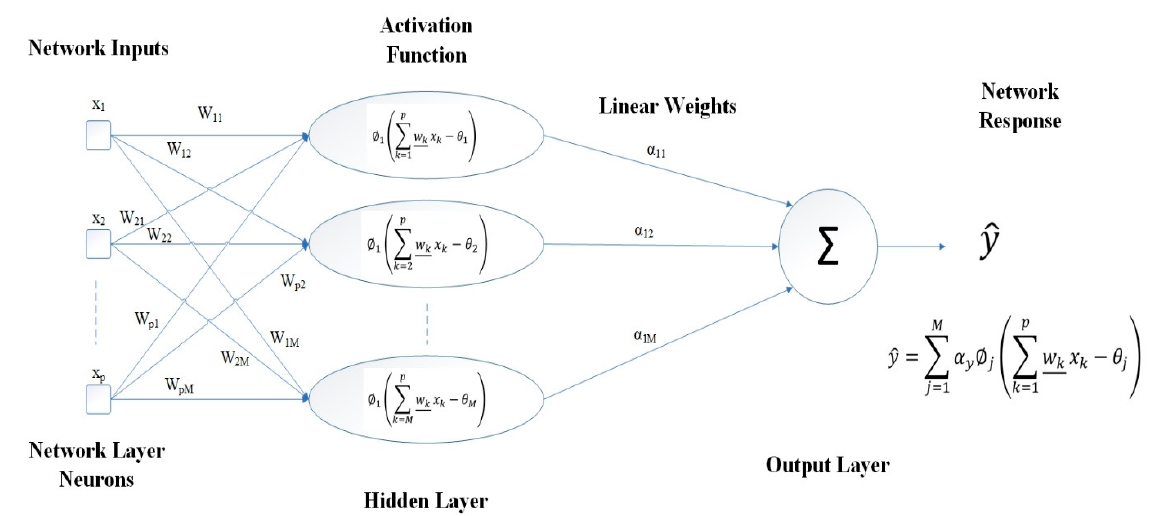
Figure 20. Flowchart of typical single line hidden layer MLP for identifying a problem.